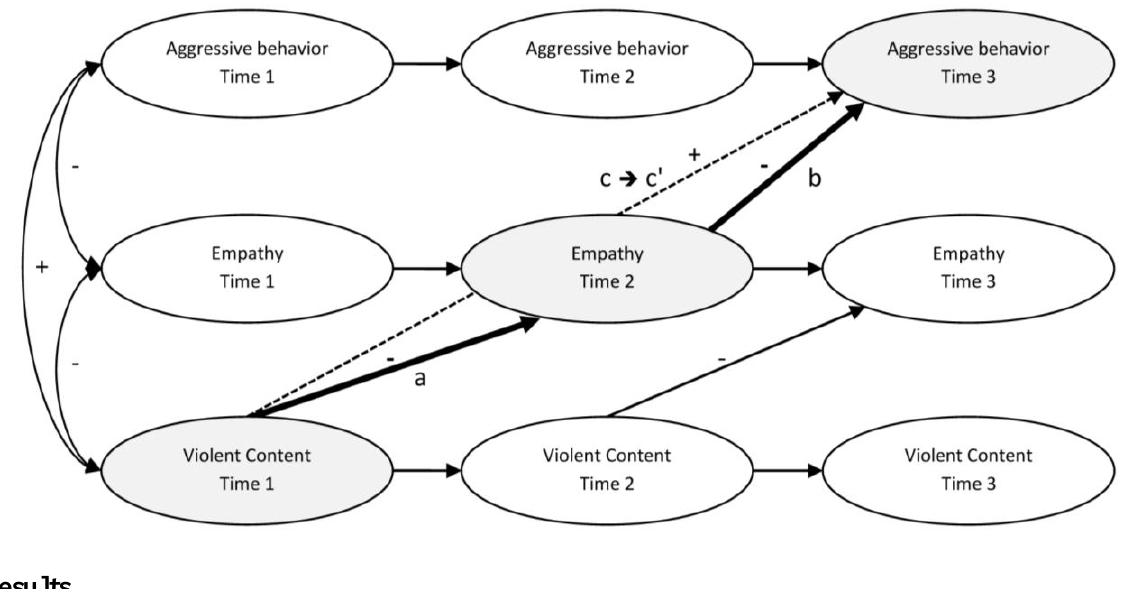
Figure 1. Hypothesized mediation model of empathy, violent content consumption and aggressive